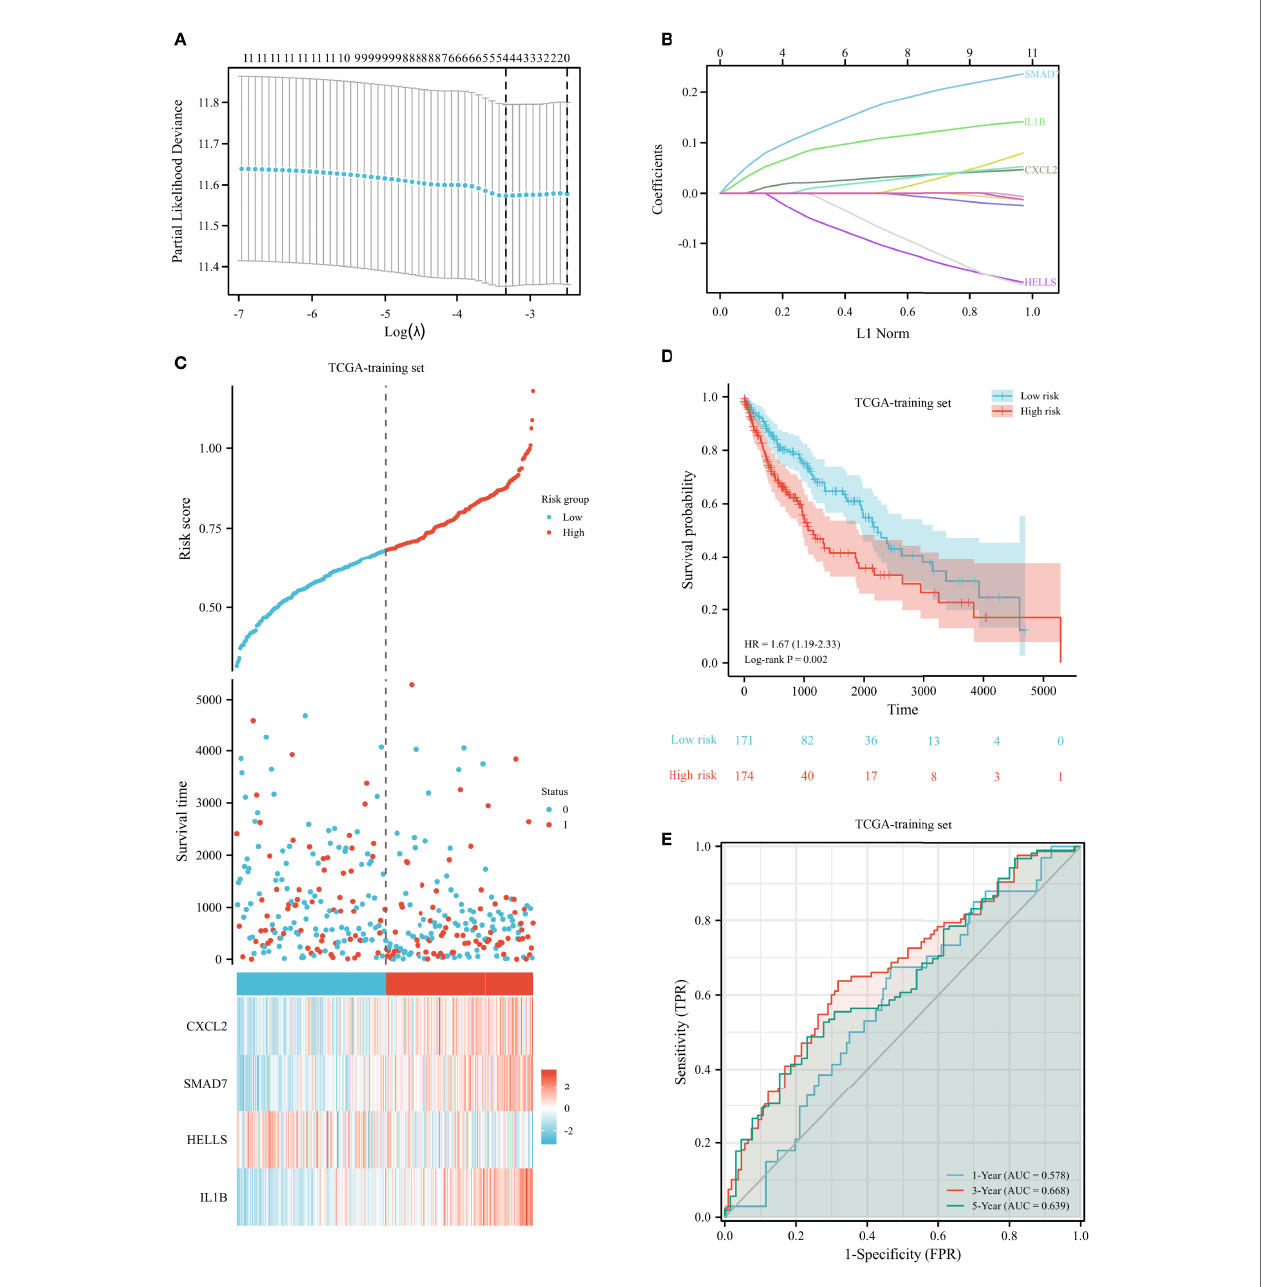
FIGURE 5 | Construction of prognostic signature for LUSC in the TCGA training set. (A) The selection of optimal predictive variables. (B) LASSO coef fi cients of the 12 variables. (C, D) Risk plot (C) and overall survival (D) between the high-risk and low-risk groups. (E) The receiver operating curve for overall survival over time.